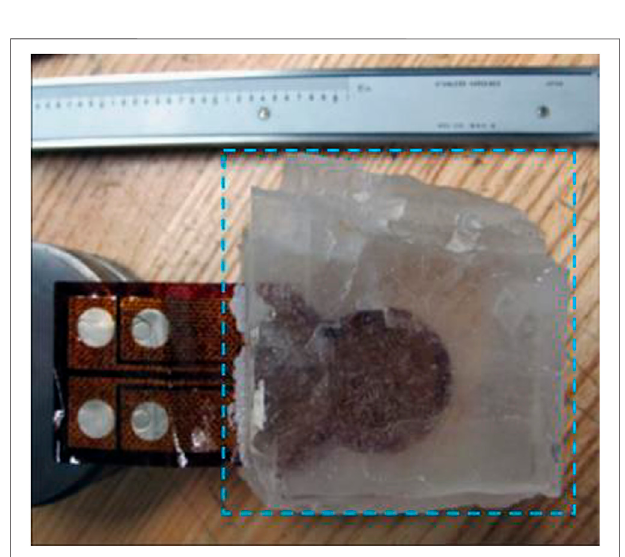
FIGURE 6 | NaCl single crystal mined in situ from Hockley salt mine (Urquhart and Bauer, 2015)